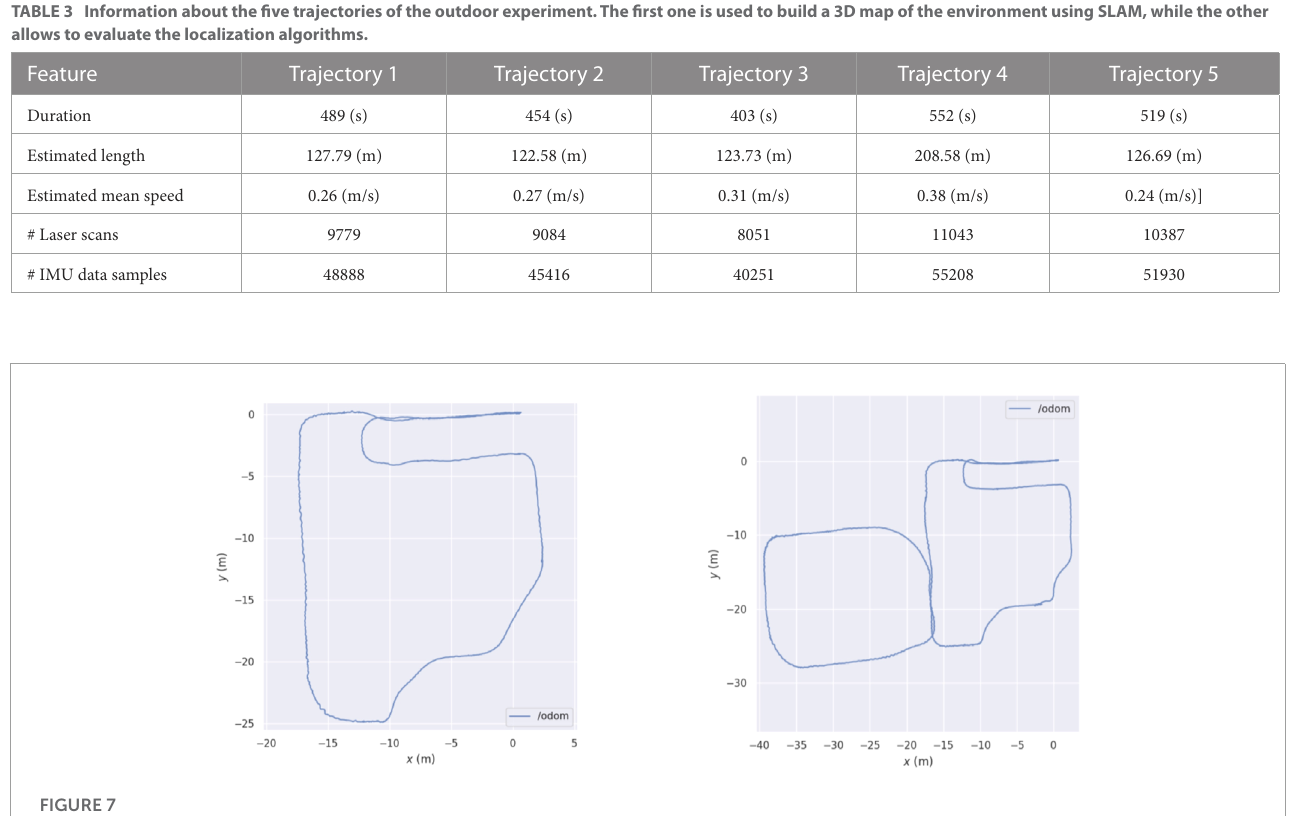
FIGURE 7 Difference between the first and fourth trajectories of the outdoor experimental campaign.